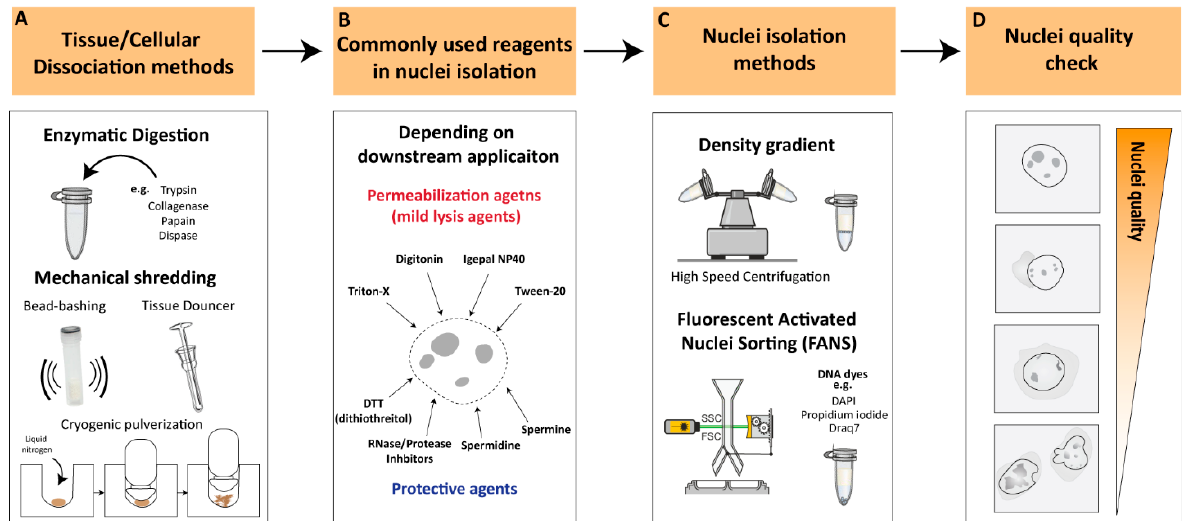
Figure 1. Key considerations for nuclei-isolation procedures ( A ). Tissue/cellular dissociation methods. Various cellular dissociation methods have been developed to isolate nuclei from different sources, such as enzymatic digestion, mechanical techniques and a combinatorial approach. ( B ). Reagents for nuclear permeabilization. Use of appropriate permeabilization buffers is crucial to ensure efficient and specific permeabilization of nuclei depending on downstream applications. ( C ). Nuclei-isolation methods. Density gradient centrifugations or flow-cytometry-based sorting are the most commonly used approaches for nuclei isolation. ( D ). Nuclei quality check. Illustration of high-quality nuclei are characterized by intact, round-shaped nuclei while low-quality nuclei often appear as small or fragmented particles with cytoplasmic debris or cellular aggregates. Low-quality nuclei could result in leakage of nuclear material from damaged or ruptured nuclei leading to contradictory